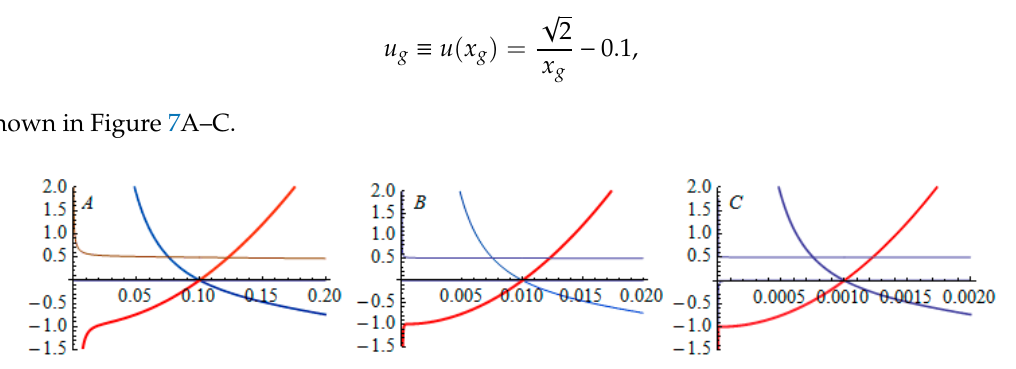
x (and a simultaneous g